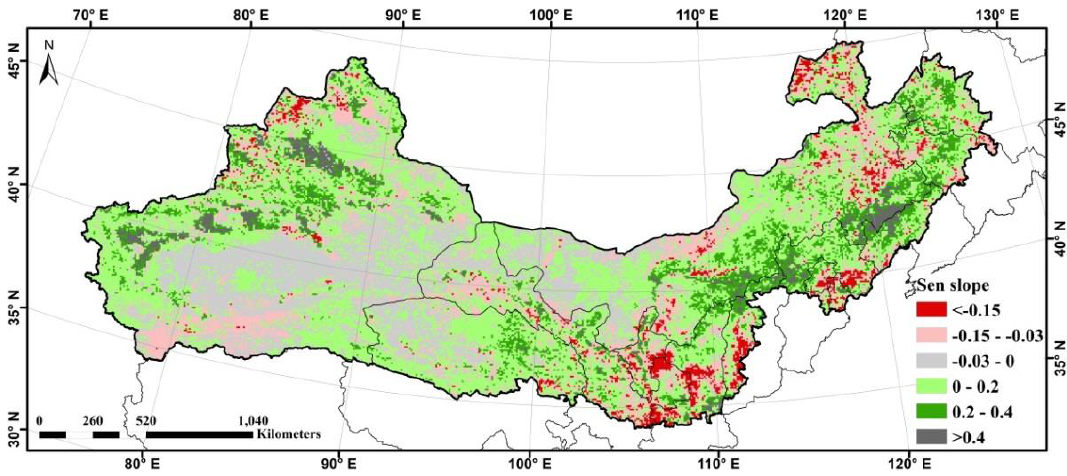
Figure 2. Spatial pattern of the Sen slope of the NDVI time-series in growth seasons from 1982–2006.